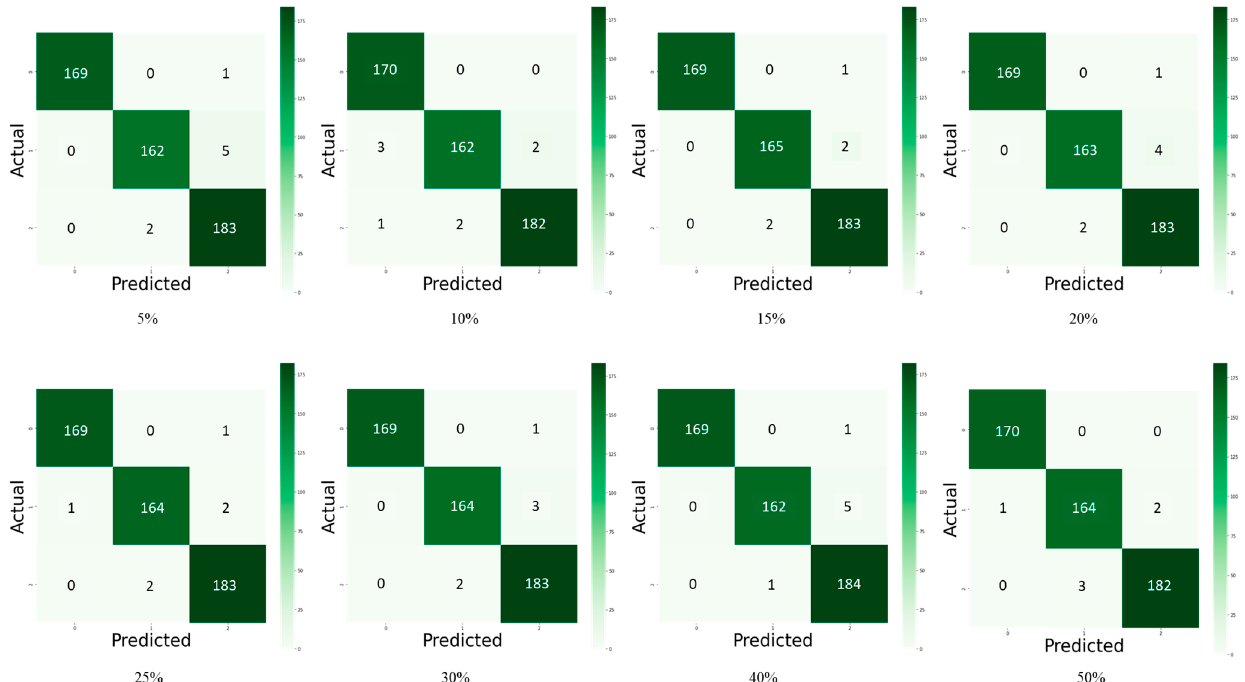
Figure 5. Confusion matrix of tomato leaf disease detection for Inception V3 model with 5%, 10%, 15%, 20%, 25%, 30%, 40%, and 50% dropout values, numbers represent the classes used for testing where : 0 = Early Blight, 1 = Yellow Leaf Curl Virus, and 2 = Healthy.